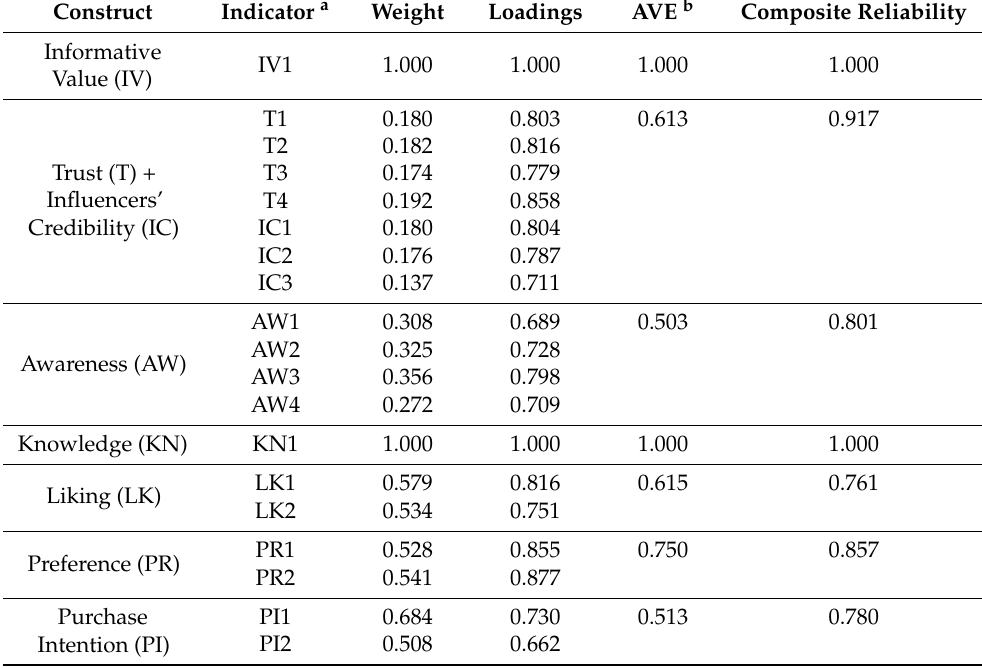
Table 2. Measurement model